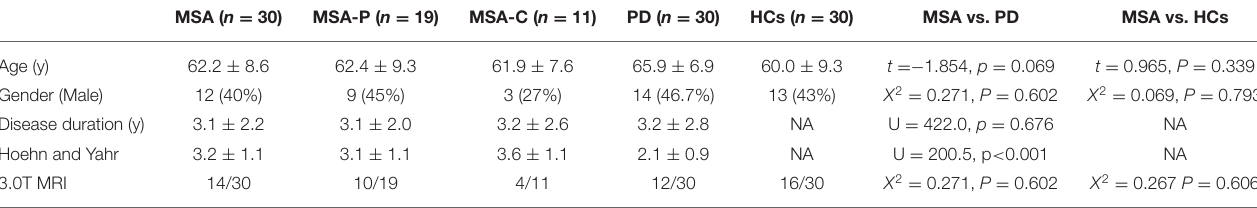
TABLE 1 | Demographic characteristics of the subject groups.